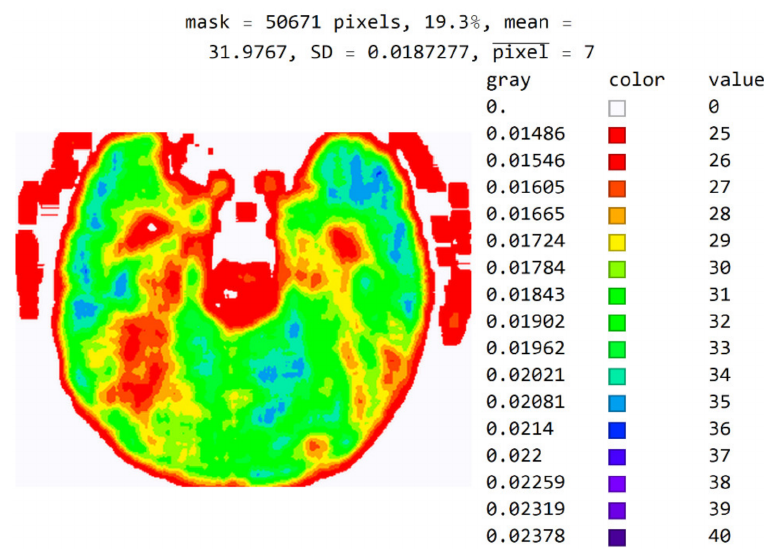
Figure 12. An image display with averaged seven adjacent pixels on a color map of the visible spectrum from pixel values 25 to 40. All other pixels outside this range have a value of 0 and are displayed in